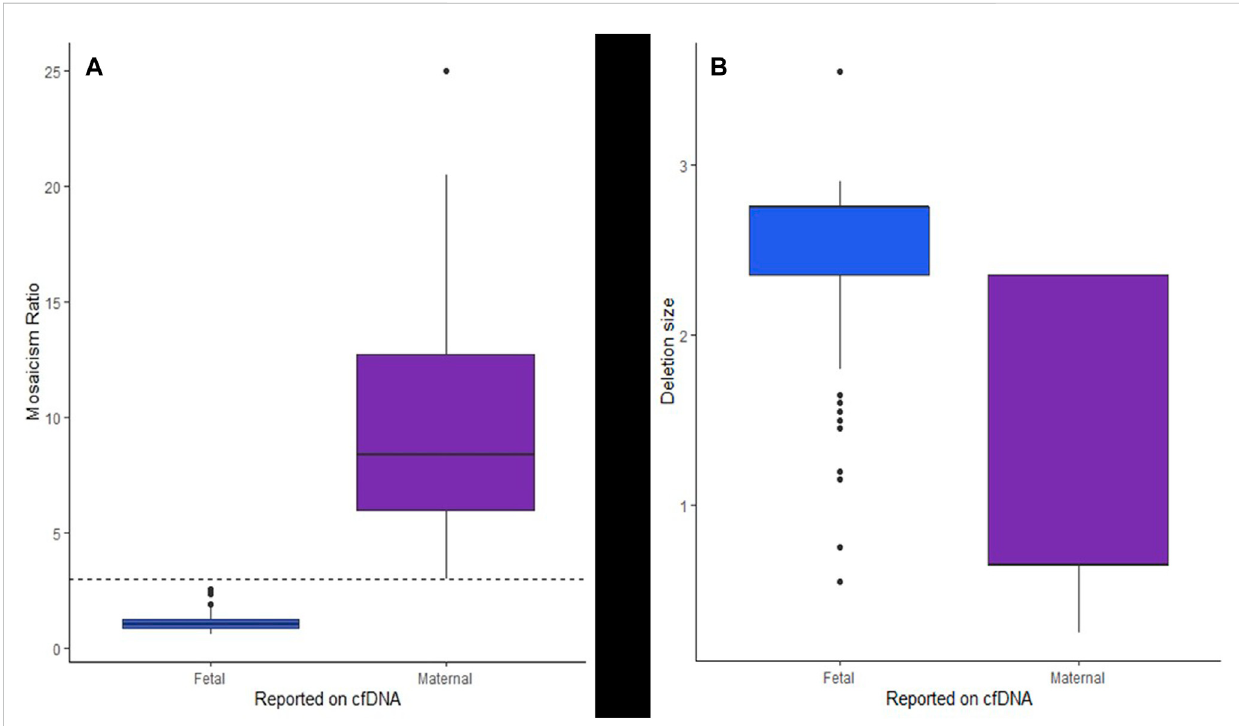
FIGURE 3 Box and whisker plots showing (A) the separation of the MR of suspected fetal and suspected maternal cases from cfDNA and (B) the estimated deletion sizes for suspected fetal events as compared to suspected maternal events from cfDNA.